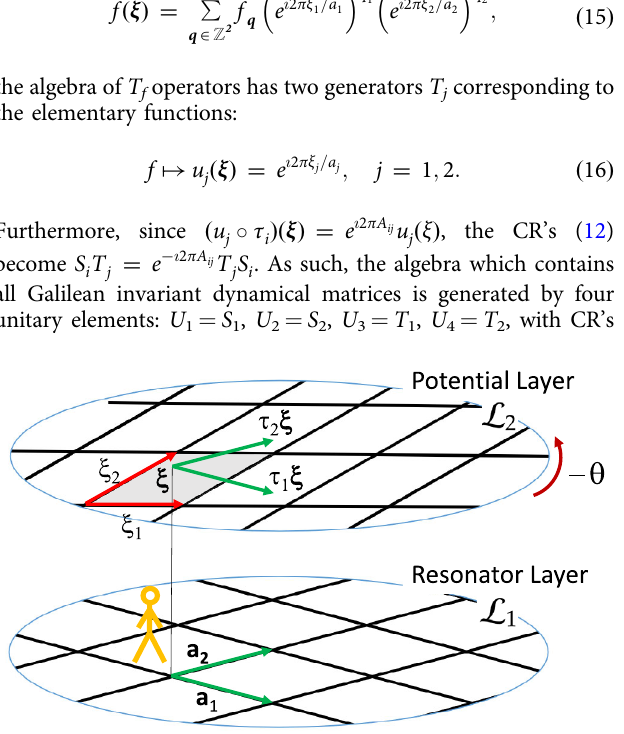
Fig. 5 Derivation of the phason space. An observer can reproduce the entire bilayer from the coordinates ( ξ 1 , ξ 2 ) of the origin of L 1 relative to the shaded primitive cell of L 2 . If the observer moves to different resonators on the L 1 lattice, this results in shifts over the folded R 2 = L 2 space generated by τ 1 ( ξ ) and τ 2 ( ξ